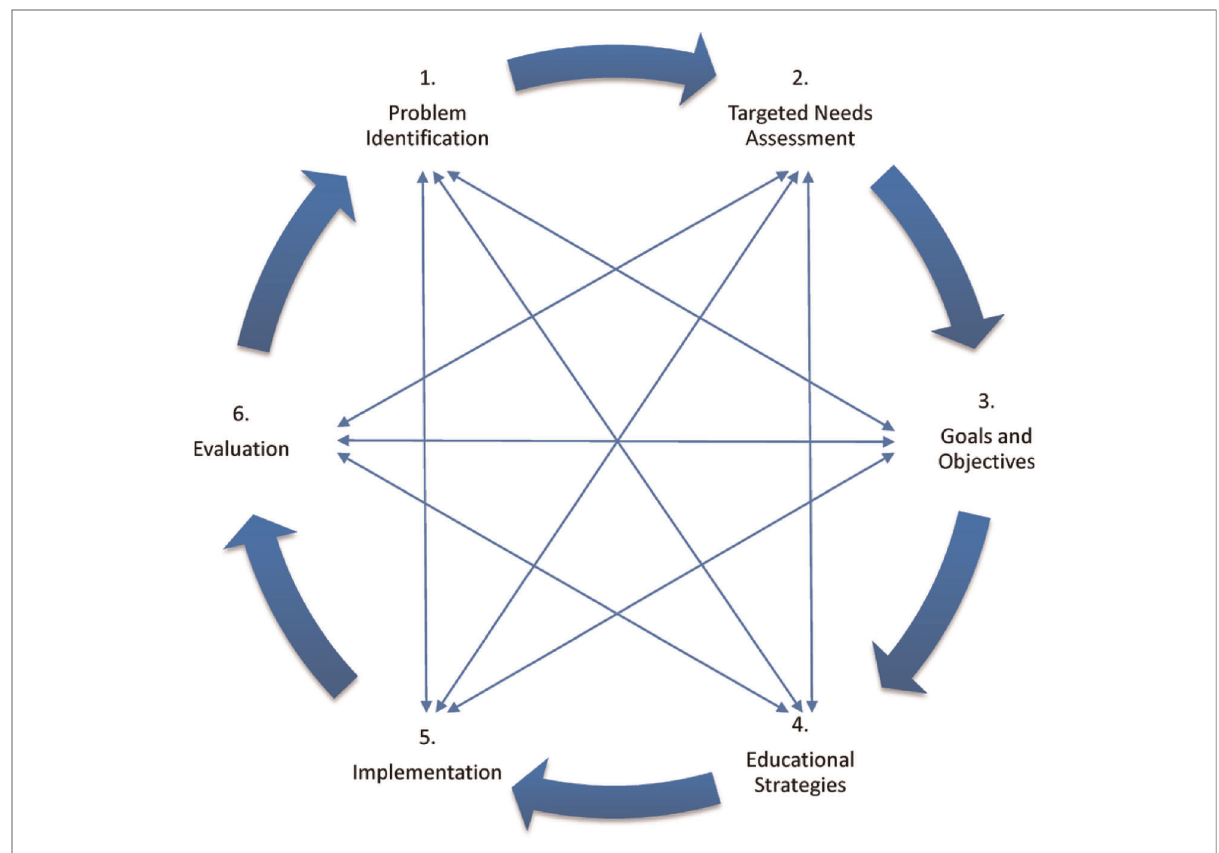
FIGURE 1 KERN cycle for medical curriculum development